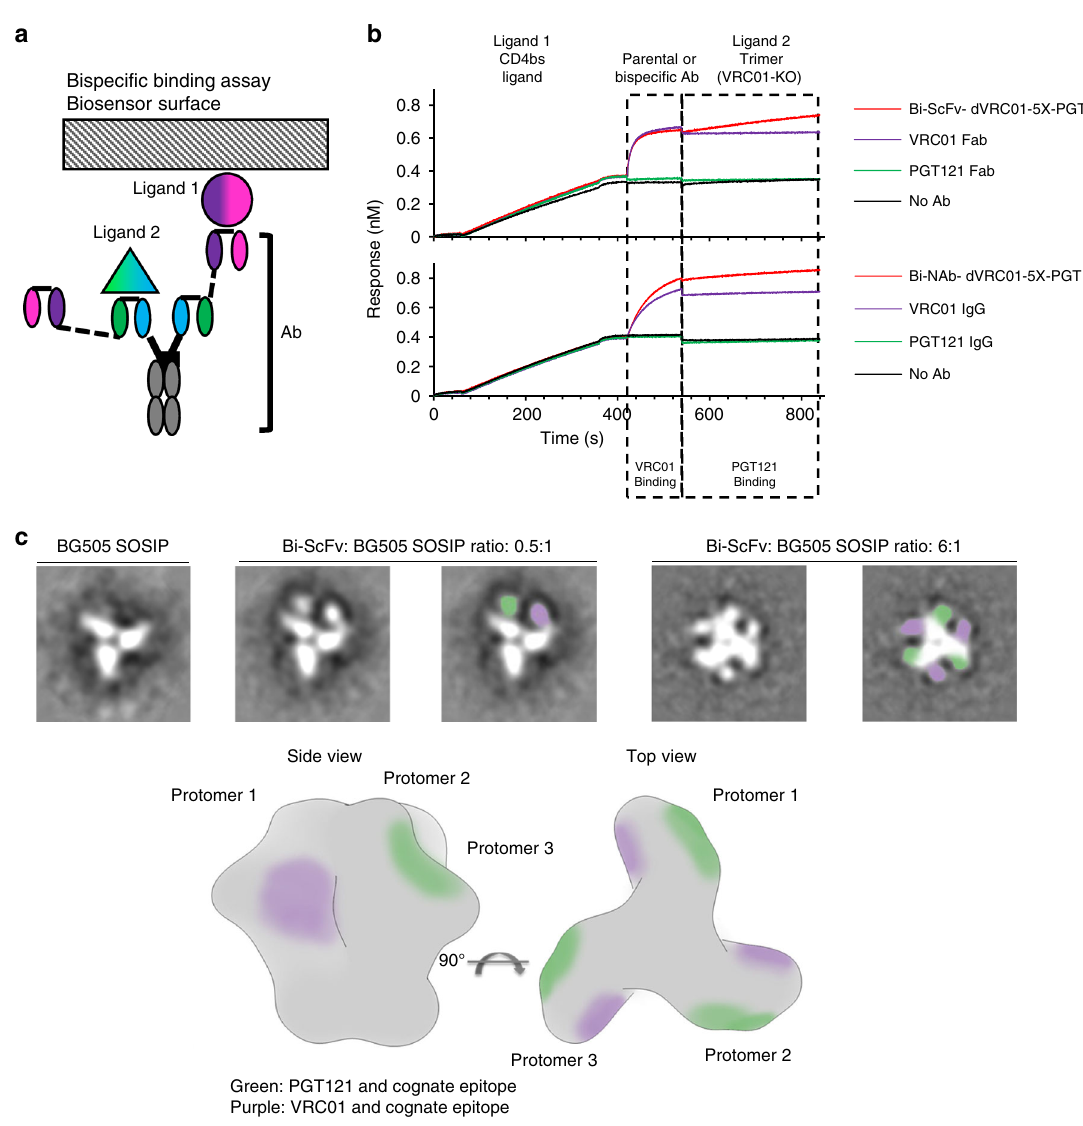
Fig. 3 Binding characteristics of anti-Env bispeci fi c antibodies. a Schematic diagram of the bispeci fi c binding assay via biolayer interferometry (BLI). b BLI response curves of bispeci fi c binding assay. OCTET biosensors were loaded with biotinylated RSC3 (ligand 1) presenting the CD4bs epitope, and then probed sequentially with the bispeci fi c antibody and BG505 SOSIP.664_D368R trimer (ligand 2) presenting the V3 glycan epitope. As controls, parental IgGs were used in place of the bispeci fi c antibody. c Upper, negative stain EM of Bi-ScFv dVRC01-5X-PGT121 , in complex with BG505 SOSIP.664 Env at a molar ratio of 0.5:1 (second from left and middle panel) and 6:1 (second from right and right panel). The PGT121 and VRC01 variable regions are highlighted in green and purple, respectively (middle and right panel); Lower, schematic presentation of Env trimer and the epitopes for PGT121 (green) and VRC01 (purple), side view (left), and top view Δ E1I2/V3S (Fig. 2a) displayed the best neutralization breadth (90% virus coverage; Fig. 4a, Supplementary Fig. 3A-B).